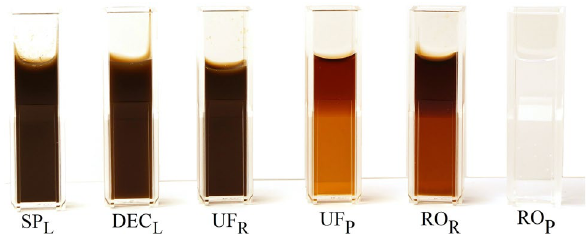
L ), supernatant from L ), solid phase from screw press (SP S ), superna-